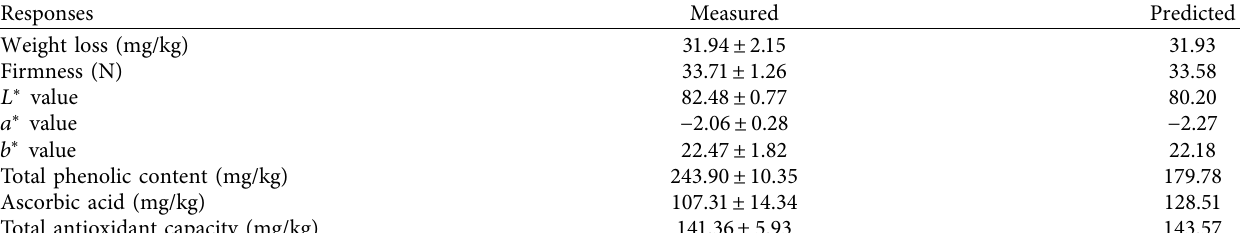
Table 3: Predicted and measured physicochemical responses of the optimized coating conditions.